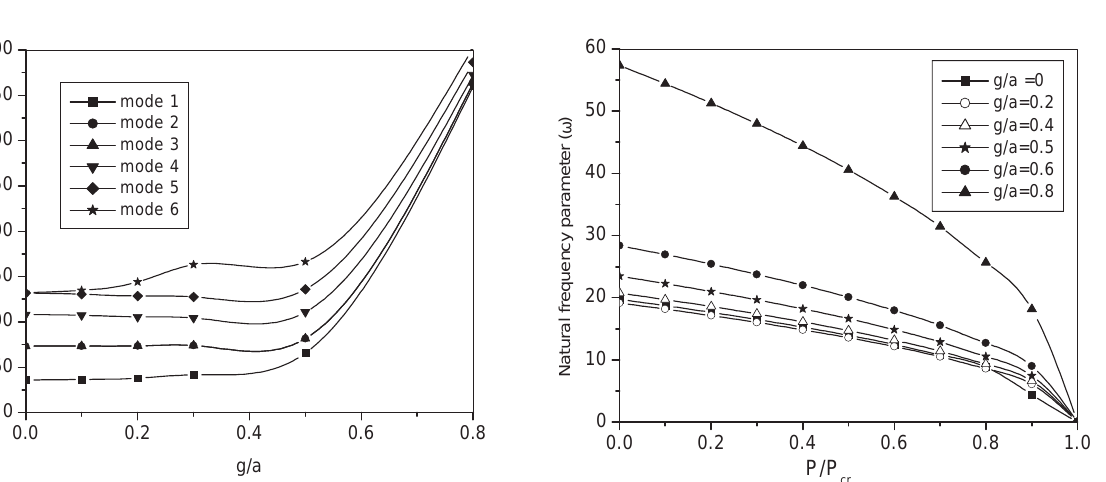
Fig. 4. The natural frequency parameter of a simply supported plate.